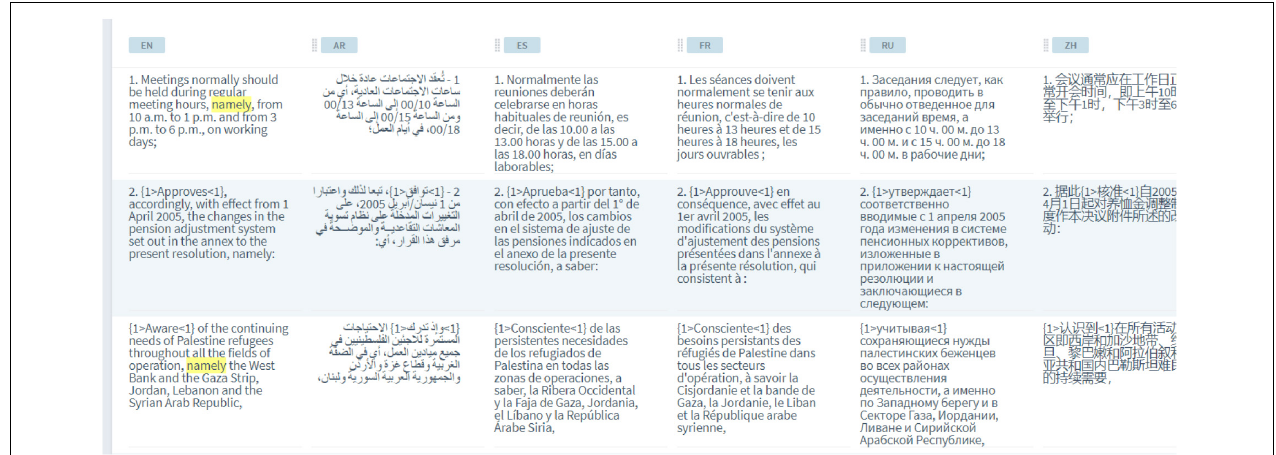
FIGURE 3 | United Nations (UN) parallel